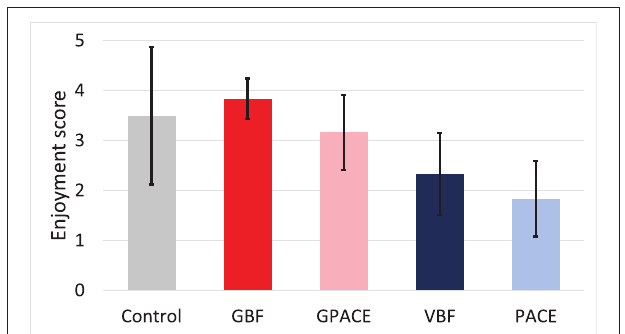
FIGURE 7 | Enjoyment score reported by the participants across the five